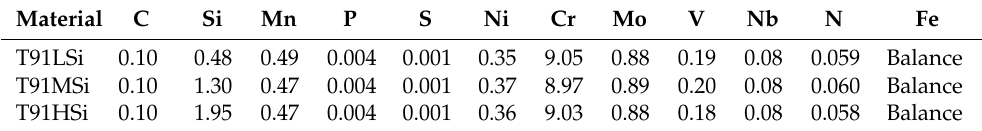
Table 1. Chemical composition of test steels